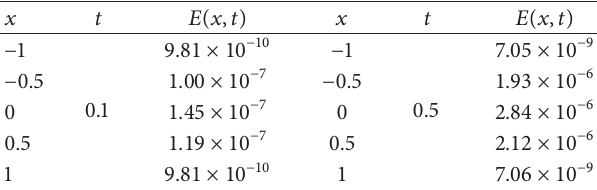
Figure 6: The curves of approximate solutions and the exact solutions of problem (35) at 𝑡 = 0.0 , 𝑡 = 0.5 , and 𝑡 = 0.9 with ] = 𝛾 = 10 −2 , 𝛿 = 2 , and 𝑁 = 20 . Table 3: Absolute errors for Example